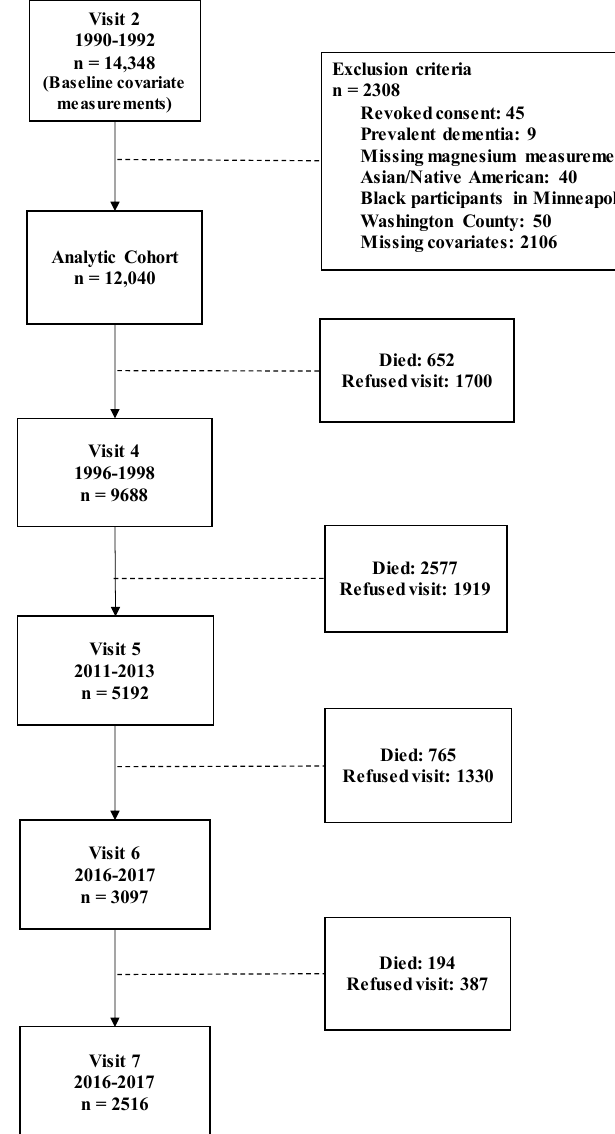
Figure 1. Diagram of the analytic cohort selection from visits 2 through 7 within Atherosclerosis Risk in Communities (ARIC) cohort.